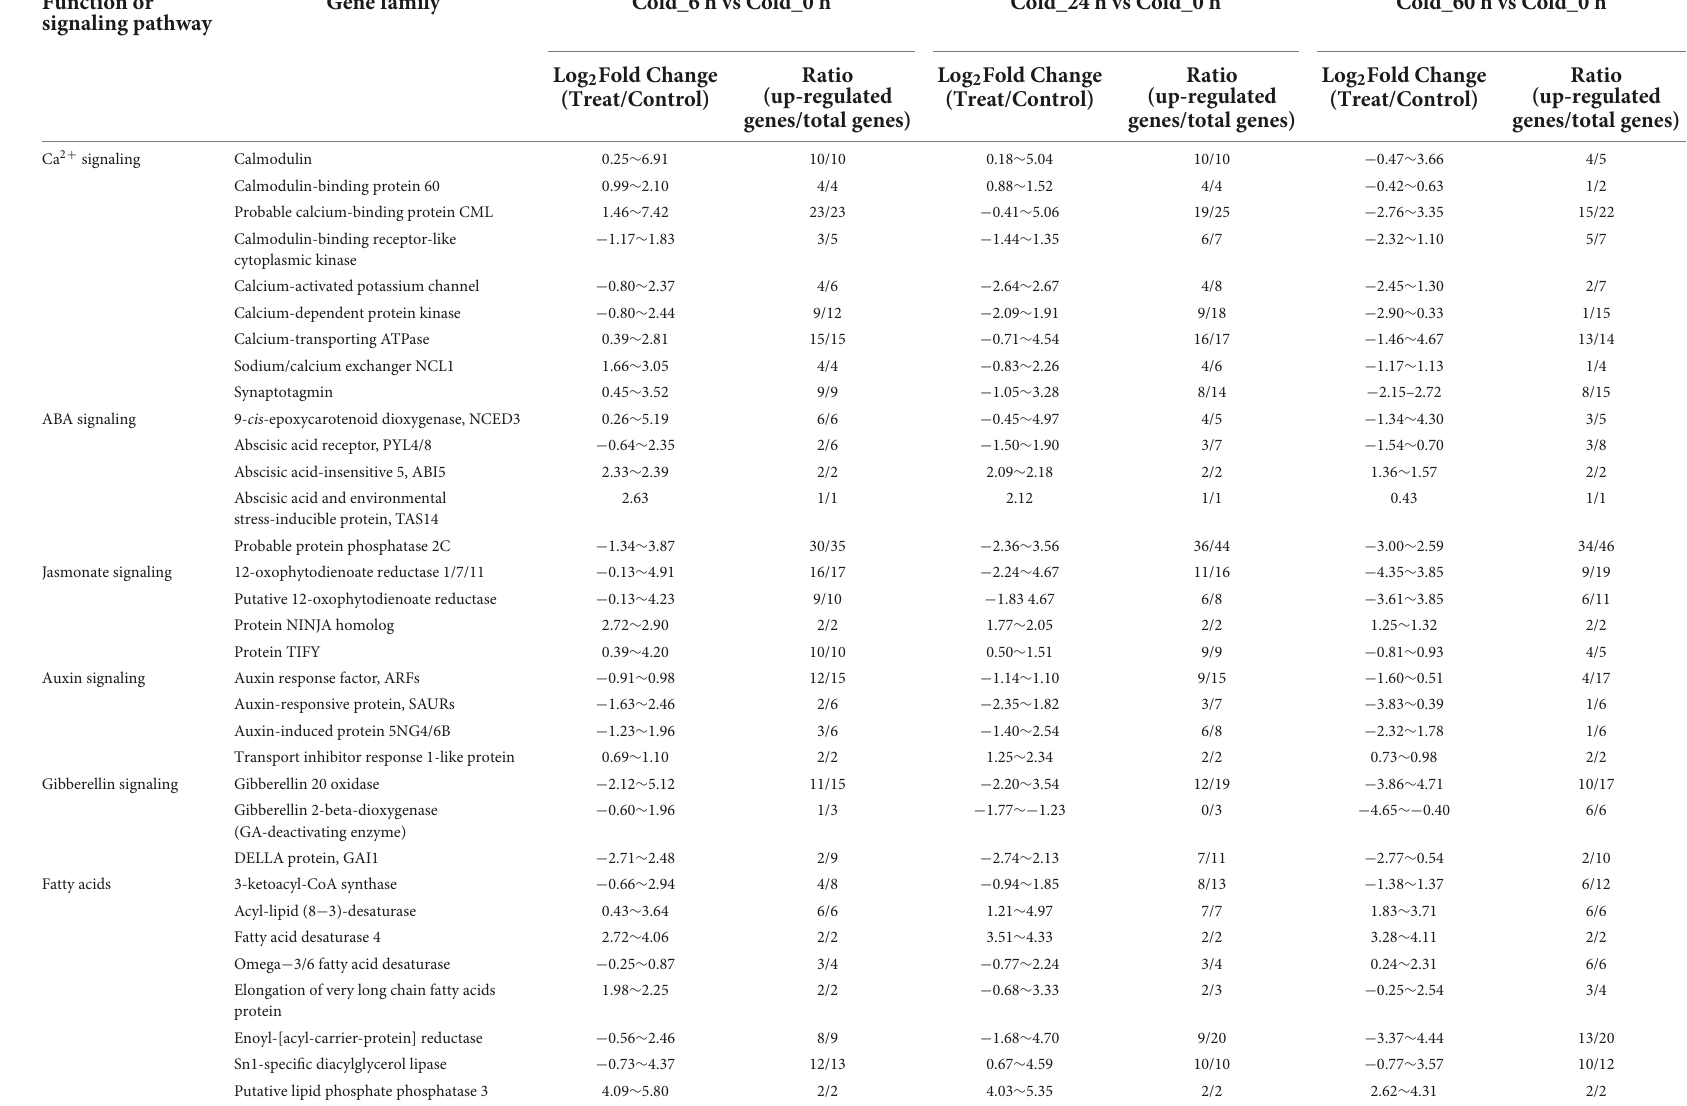
TABLE 1 Representative cold stress-related genes of the Antarctic moss Pohlia nutans. Data were summarized from the Supplementary Tables 8–10 . Function or signaling